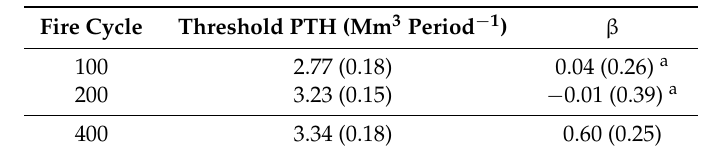
Figure 3. Probability distributions of the success rate of the simulated harvest schedule implementation under current (( a ) 400 years) and probable future fire regimes (( b ) 200 years; ( c ) 100 years). From bottom up, broken and bold lines represent the 5th, median and 95th percentiles. One hundred percent represents the target (continuous line) and ninety percent correspond to a cutoff value below which a timber supply disruption was considered to occur [57]. Table 1. Parameter values of piecewise linear models with one knot (threshold planned timber harvest (PTH)) (Equation (8)) relating PTH and periodic median realized harvest levels implemented with the landscape simulation model under current (400 years) and probable interval for future fire regimes (100 and 200 years).